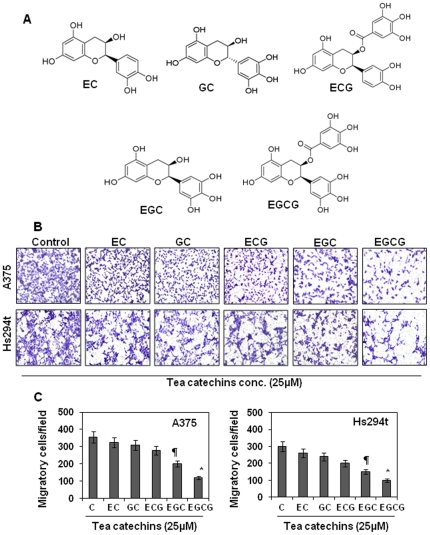
Comparative effects of green tea catechins on the cell invasion capacity of melanoma cells.(A) Chemical structures of major green tea catechins. EC, (-)-epicatechin; GC, (-)-gallocatechin; ECG, (-)-epicatechin-3-gallate; EGC, (-)-epigallocatechin, and EGCG, (-)-epigallocatechin-3-gallate. (B) Effect of equimolar concentration (25 µM) of various green tea catechins on the migration of human melanoma cells (A375 and Hs294t) after treatment for 24 h. (C) The migrating cells were counted and the results expressed as the mean number of migratory cells ± SD/microscopic field. Data collected from three independent experiments. Significant inhibition by EGC and EGCG versus non-tea catechins-treated controls, ¶
P<0.01; *
P<0.001.